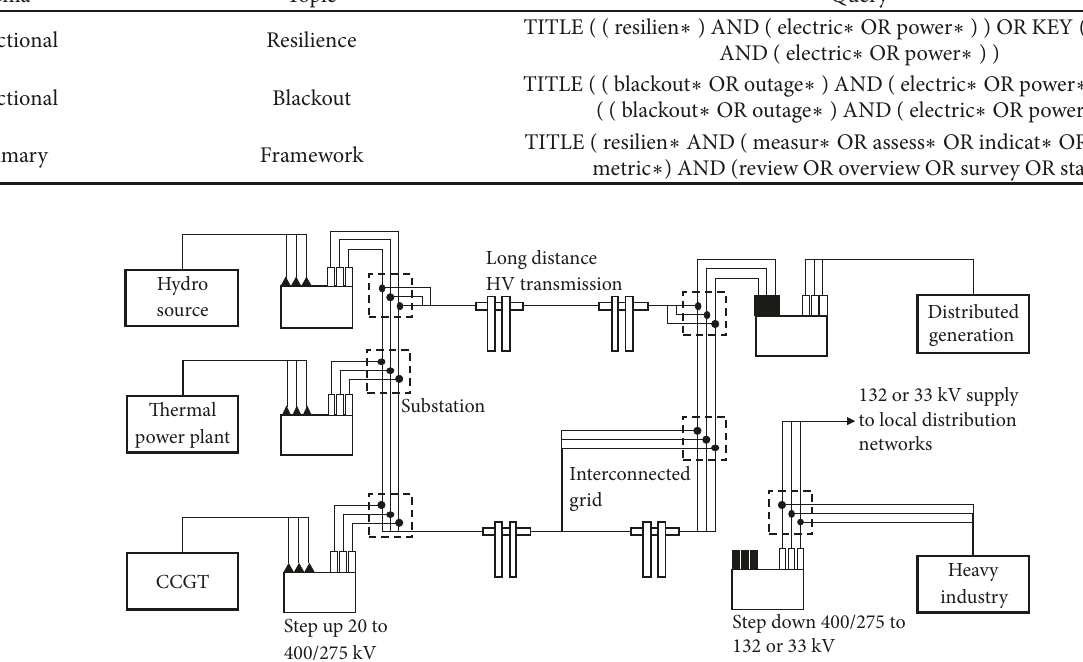
Figure 1: Generation and transmission network (UK voltages and practice)